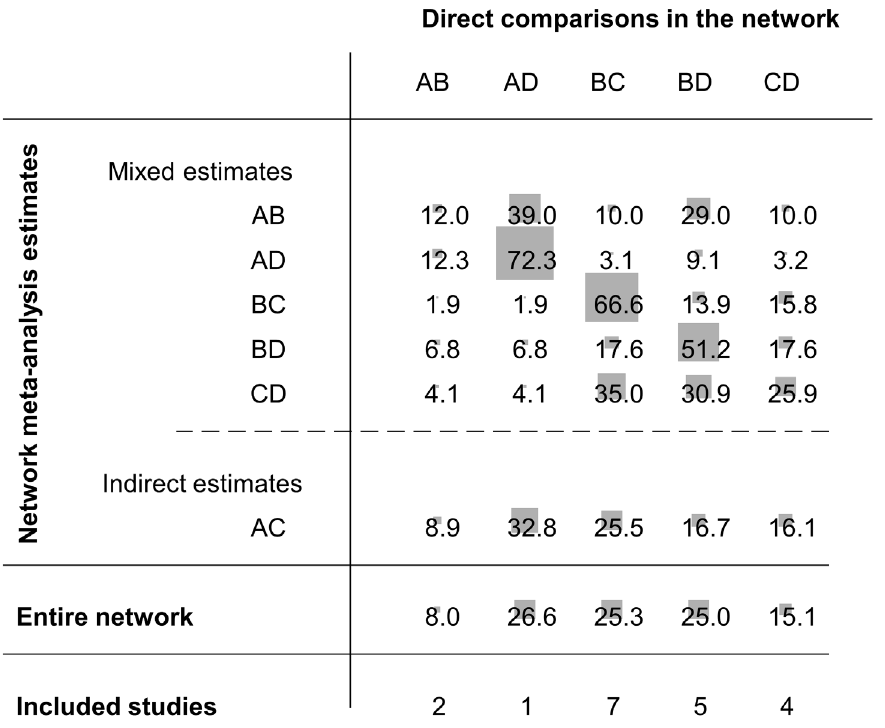
Figure 2. Contributions matrix: percentage contribution of each direct estimate to the network meta-analysis estimates. Rows correspond to network meta-analysis ORs (separated for mixed and indirect evidence) and columns correspond to direct meta-analysis ORs. The contribution of each direct comparison to the total network evidence that provides the ranking of the treatments is presented separately (row named Entire network). The sizes of the boxes are proportional to the percentage contribution of each direct estimate to the network meta-analysis estimates (rows 1–6) and to the entire network (row 7). The last row shows the number of included direct comparisons. The names of the treatments are given in Figure 1.